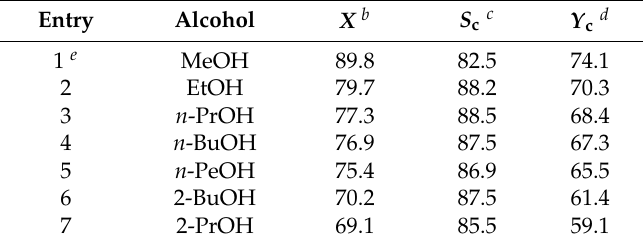
Table 2. Synthesis of dialkyl hexane-1,6-dicarbamates from 1,6-hexanediamine (HDA) a